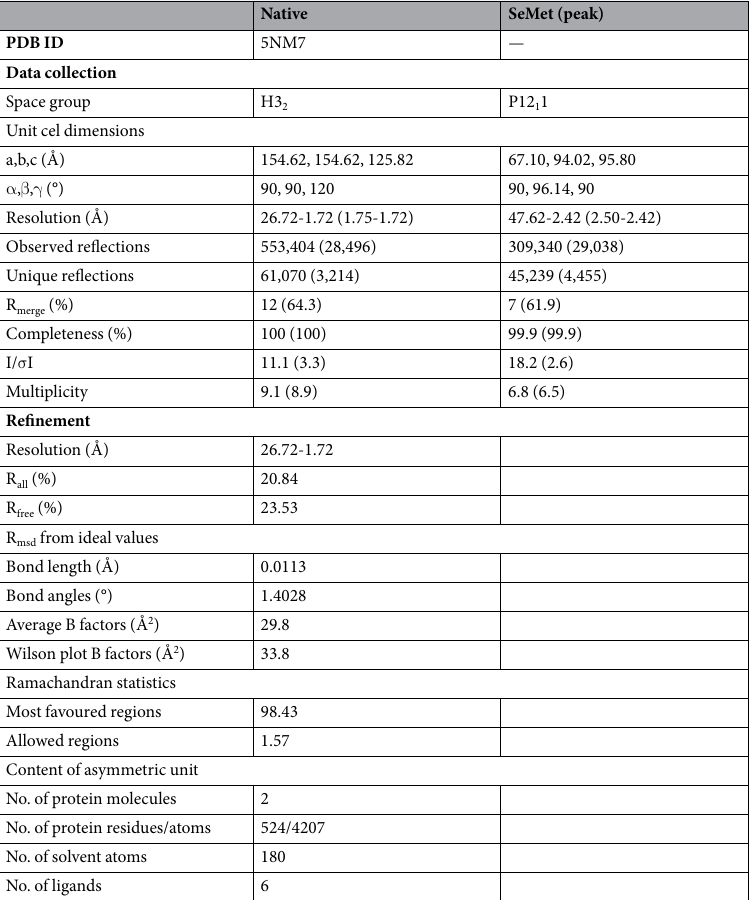
Table 1. Data collection and refinement